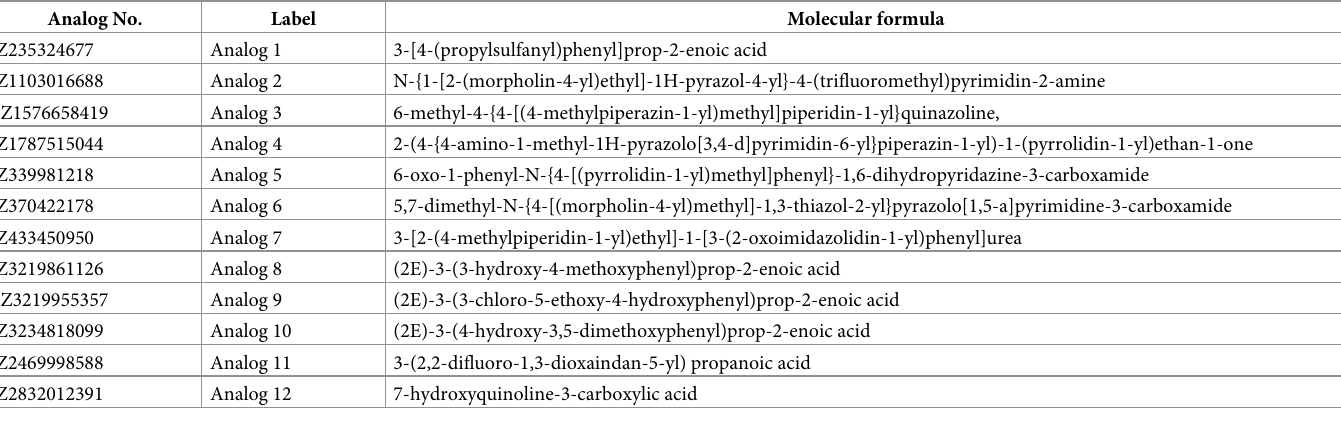
Table 1. Molecular formulae of designed analogs with their labels. Analog No.